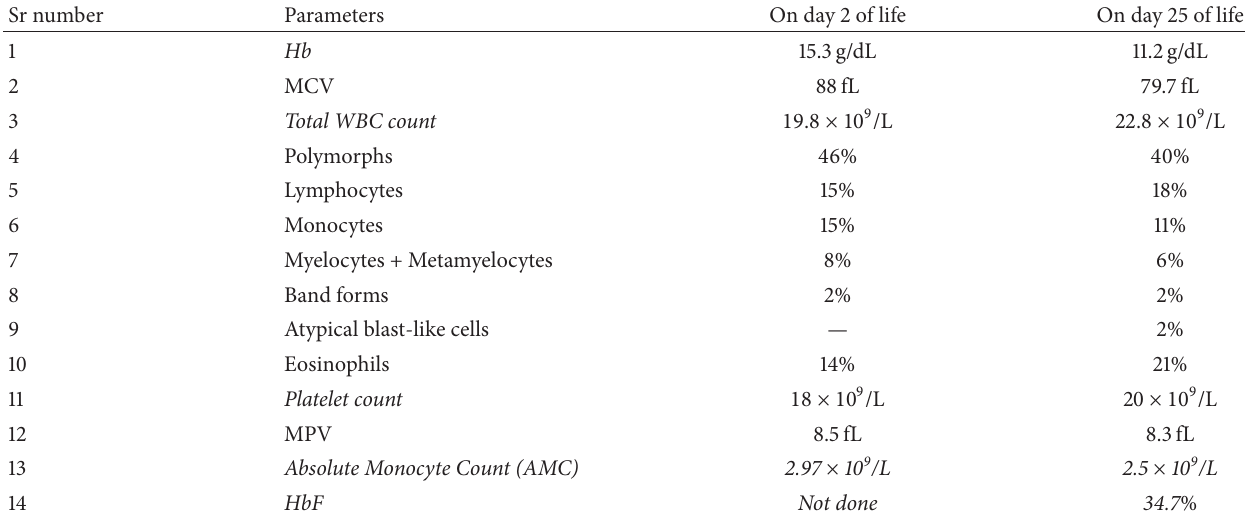
Table 1: Showing patient’s complete hemograms in two admissions.